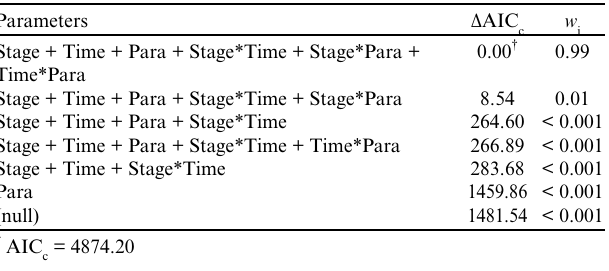
Table 5. Comparison of a priori selected models to assess the predator-attraction hypothesis and the relationship between vocalization rate by male vireos and nest stage (Stage), time of day (Time), and parasitism fate (Para). Models are compared using AIC (Akaike 1974) and model weights (wi) c Parameters